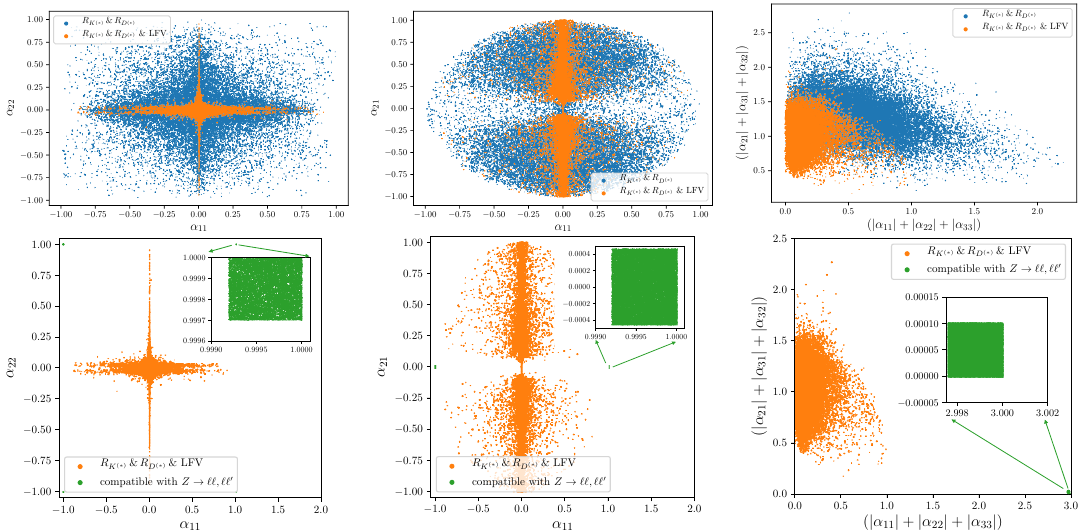
Figure 4 . On the upper row, A -matrix entries complying with R those which in addition respect all imposed (cid:13)avour constraints (yellow). Lower row: for the case of isosinglet heavy leptons , A -matrix entries complying with R bounds (yellow), and those which now further comply with bounds from Z decays (green). (Notice that the green inset area corresponds to a zoom-out of what would otherwise be a tiny region close to the border of the parameter space.) In all panels we have taken m V = 1 : 5 TeV and all mixing angles have been varied randomly between (cid:0) (cid:25) and (cid:25)